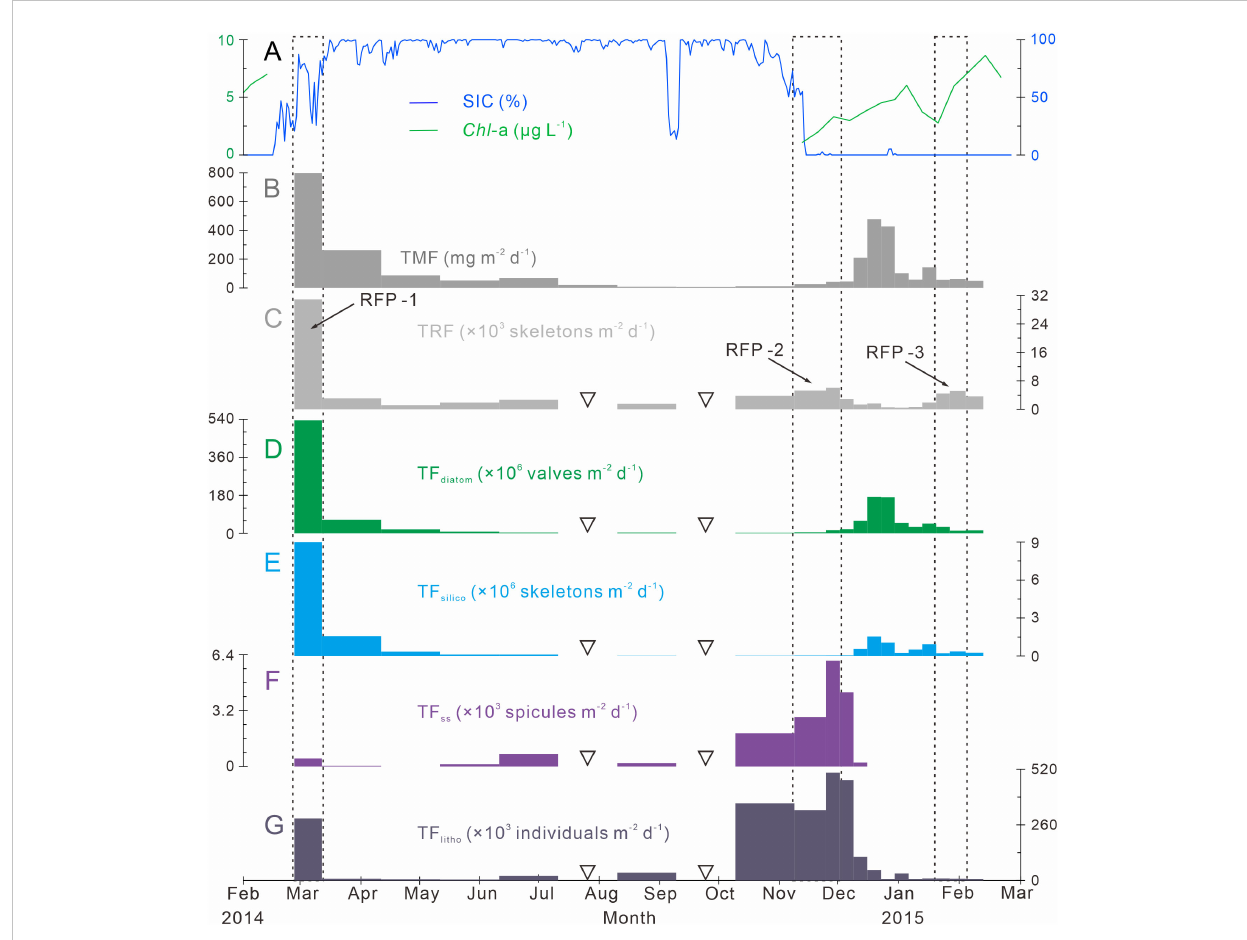
FIGURE 3 Time-series variations of particle fl uxes, SIC (%) and Chl- a ( m g L − 1 ) in Prydz Bay polynya. (A) Distributions of SIC (%) and Chl- a (µg L − 1 ). SIC data were retrieved from the University of Bremen (http://www.iup.uni-bremen.de:8084/amsr2); Chl -a data from the Aqua-MODIS products (http://hermes. acri.fr). (B) TMF, total mass fl ux (Han, 2018). (C) TRF, total radiolarian fl ux. RFP-1 – 3 are three radiolarian fl ux peaks (black dotted lines). (D) TF diatom , total diatom fl ux. (E) TF silico , total silico fl agellate fl ux. (F) TF ss , total sponge spicule fl ux. (G) TF litho , total lithogenic debris (< 1 mm) fl ux. The width of each bar in the histogram indicates the sampling interval, and black hollow inverted triangles mark samples that were not analyzed because the sample size was too